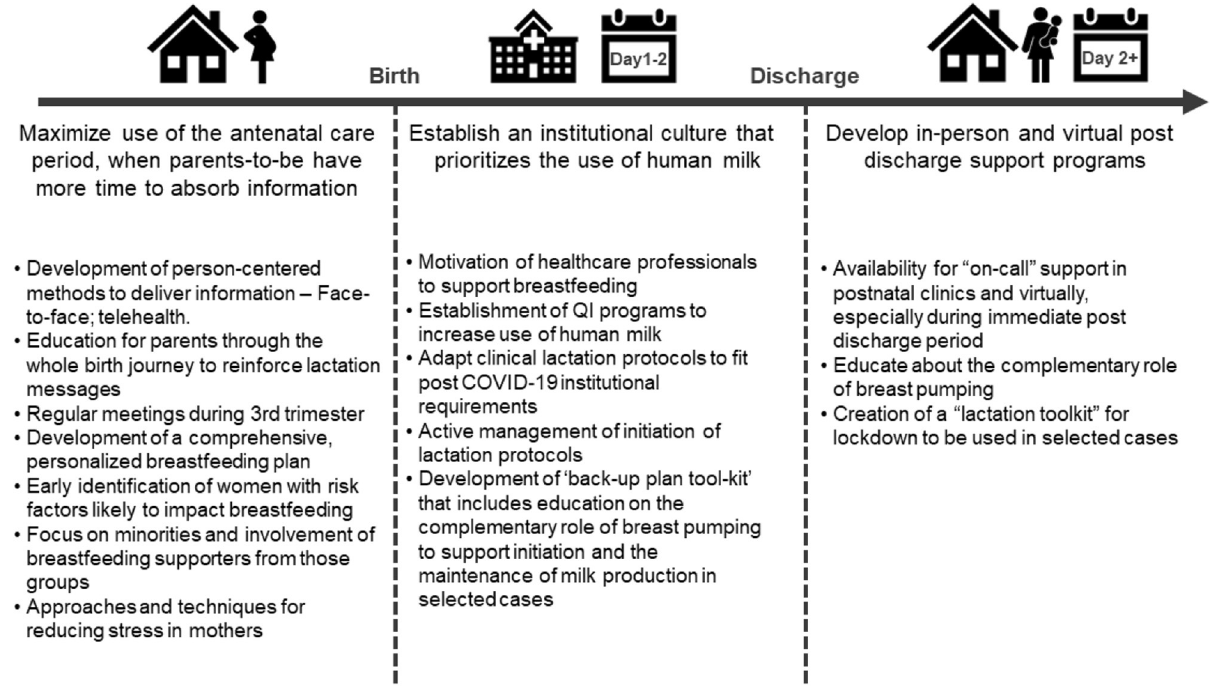
Frontiers in Pediatrics |